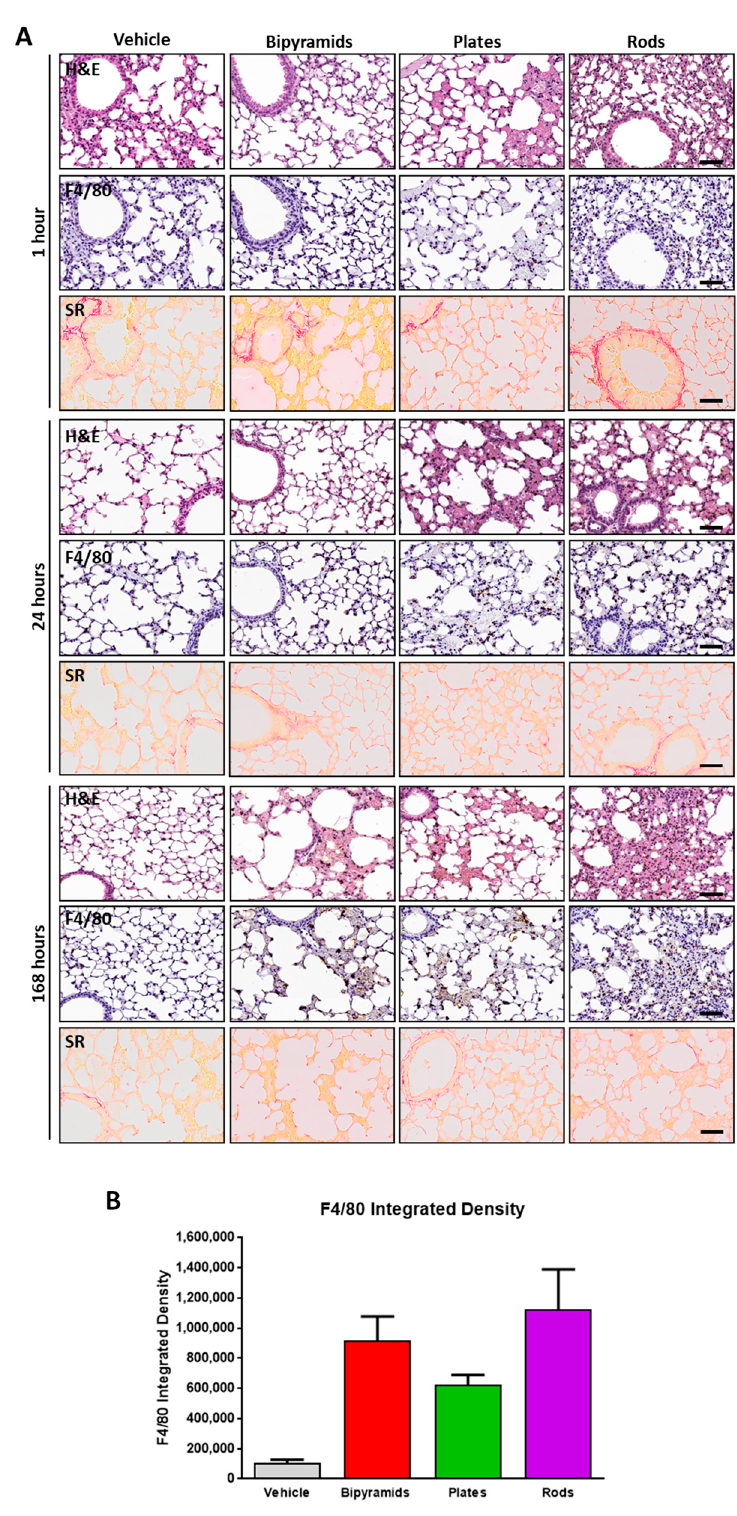
Figure 8. Lung histopathology and immunohistochemistry. ( A ) Representative micrographs (H&E, upper panels), immunohistochemical staining (F4/80, middle panels) and Sirius Red (lower panels) of the lungs of mice injected with bipyramids, plates, and rods, compared to vehicle-treated mice sacrificed at 1, 24, and 168 h after NP injection. The scale bars indicate 50 µ m. ( B ) Histogram showing the spread of the pattern of immunoreactivity from sections of mice sacrificed 168 h after NP injection. The values were expressed as mean ± SEM.